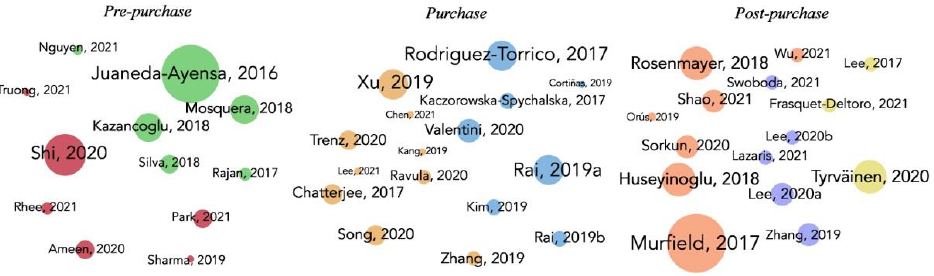
Figure 10. Bibliographic coupling at each purchase stage.